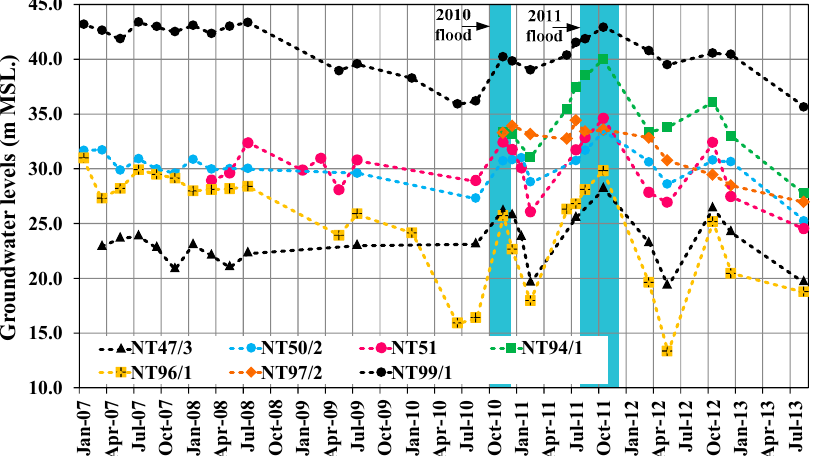
Figure 6. Temporal variability in groundwater levels along the Yom River. Figure 7a–d show spatial and temporal distributions of groundwater levels (m MSL.)